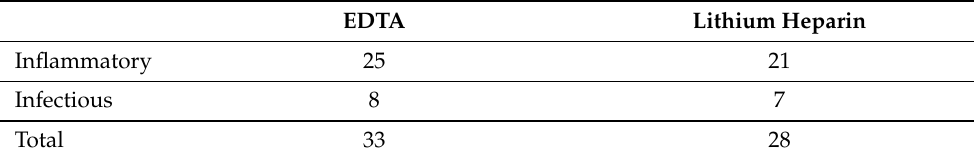
Table 1. SF samples.